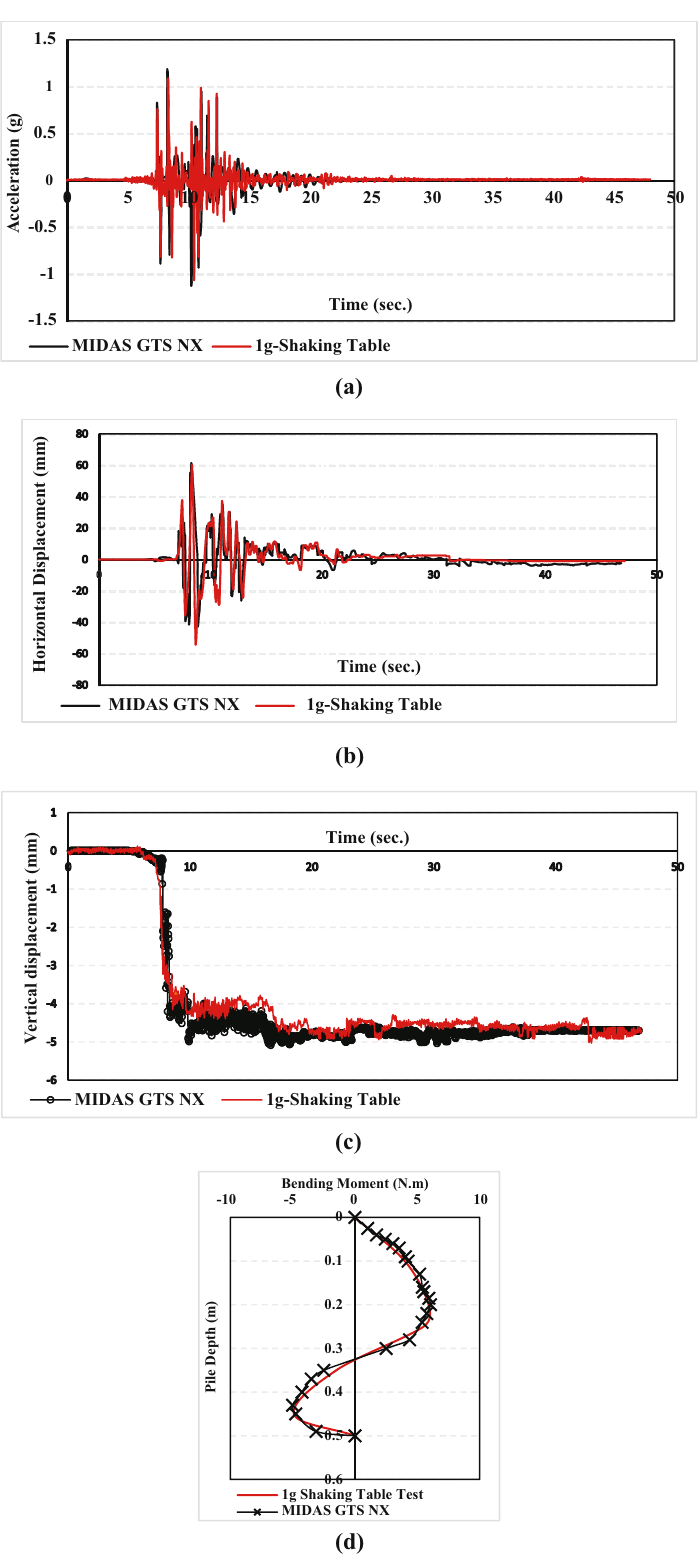
Figure 3: Model validation: ( a ) acceleration at the pile head due to Kobe earthquake excitation, ( b ) maximum lateral displacement at the pile head due to Kobe earthquake excitation, ( c ) pile settlement due to Kobe earthquake excitation, and ( d ) bending moment due to Kobe earthquake